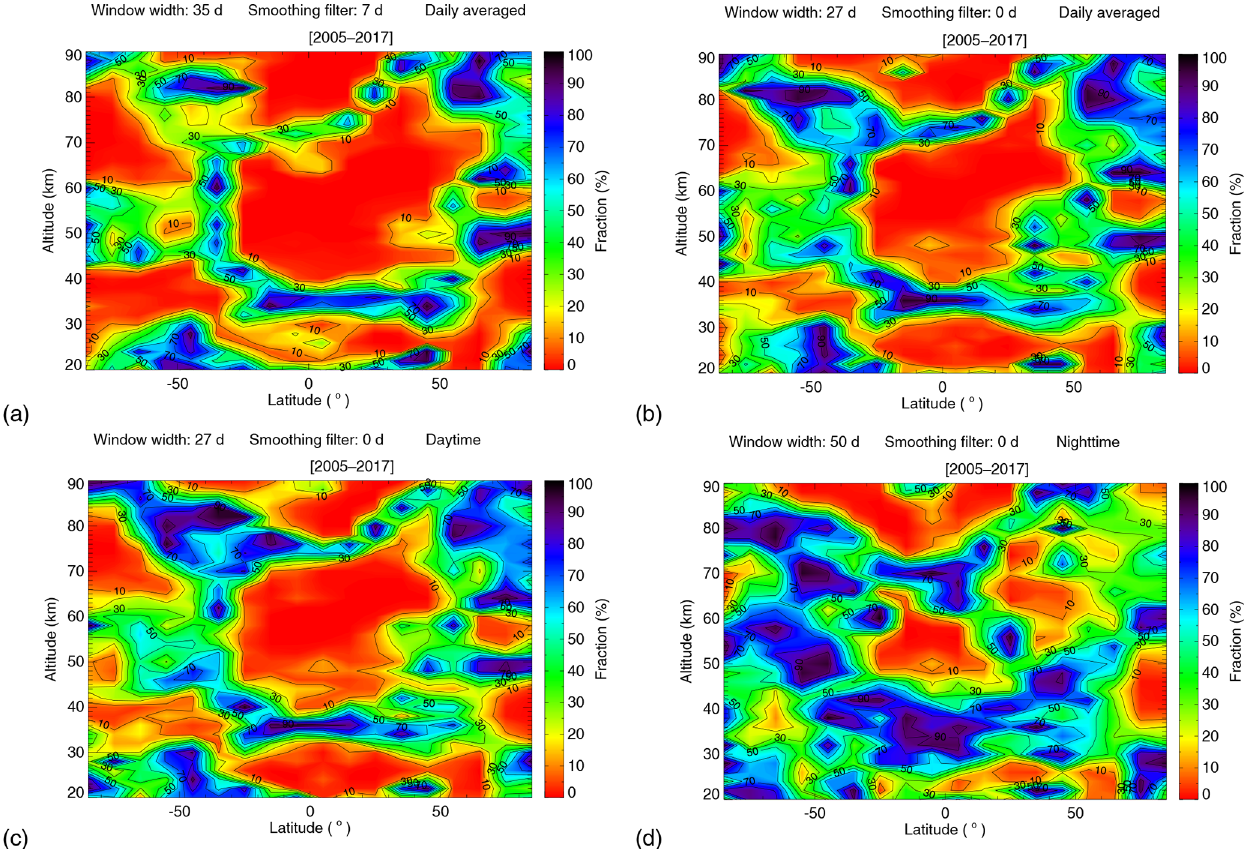
Figure 9. (a) The fraction of random realizations with amplitudes larger than the actual SEA based on the daily averaged temperature data for latitudes ranging from 85 ◦ S to 85 ◦ N and altitudes ranging from 20 to 90km. A 35d window width, 7d smoothing filter and maxima of the Mg II index anomaly are used in this test. (b) Similar to (a) except that a 27d window width and 0d smoothing filter are used. (c) Similar to (a) except that a 27d window width, 0d smoothing filter and daytime temperature data are used. (d) Similar to (a) except that a 50d window width, 0d smoothing filter, nighttime temperature data and minima of the Mg II index anomaly are used.